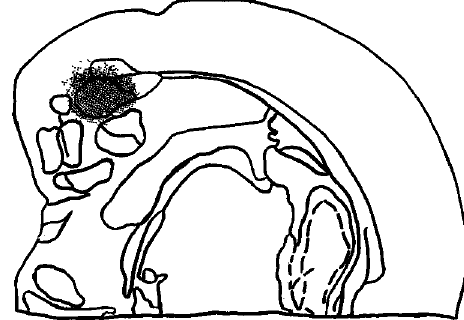
Figure 1 - Drawing of the A -2.3 mm plane of the Paxinos and Watson (21) atlas showing the area (hatched) where the micro- injections considered to be cor- rect were